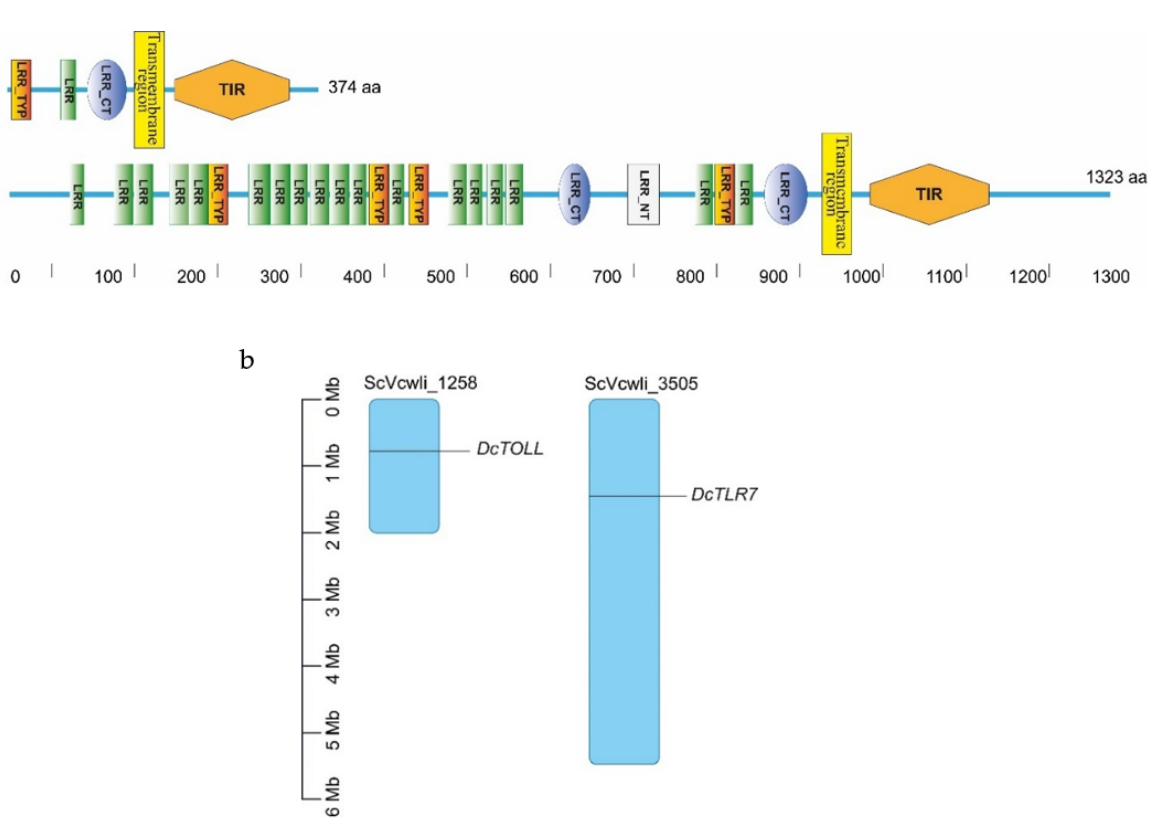
Figure 3. ( a ) Schematic representation of the domain organization of DcTLRs; different colors and shapes represent the different domains and regions. ( b ) Chromosomal localization of Diaphorina citri TLRs. The size of a chromosome is indicated by its relative length.